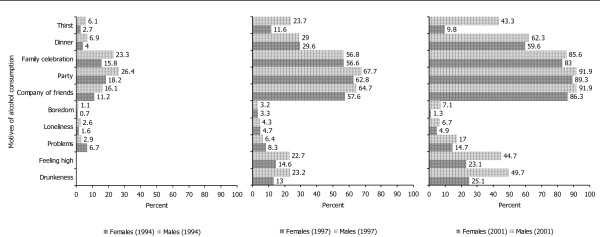
Motives of alcohol consumption at three times ("Feeling high" & "Drunkeness" were not asked at time 1).